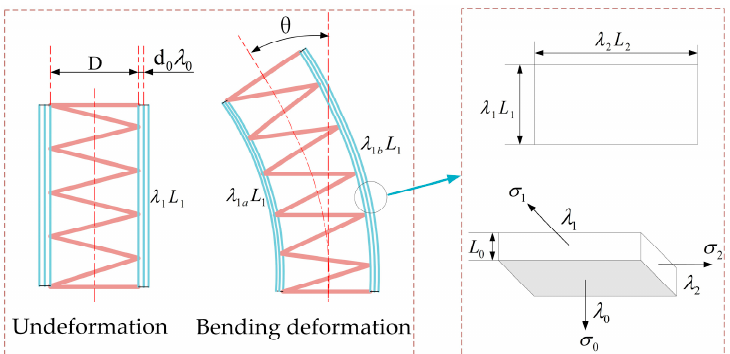
Figure 2. Force analysis diagram of the soft fingers and their